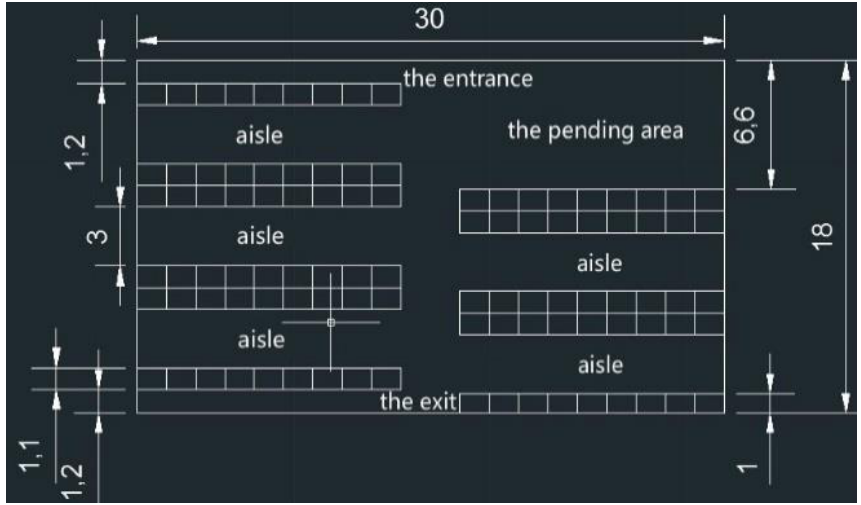
Figure 8. Pallet-type shelf storage locations.